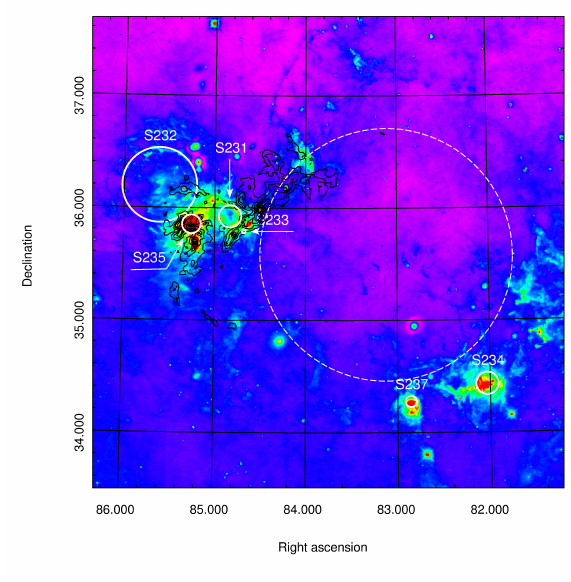
Figure 1. Image at 22 µ m by WISE centered at α (J2000.0) = 05 h 35 m 00 s and δ (J2000.0) = +35 ∘ 36 ′ 36 ′′ . The intensity scale uses an asinh stretch. Black contours represent 13 CO emission of giant molecular cloud G174+2.5 from FCRAO14-m telescope by Ladeyschikov et al. (2016). Contours are generated from 1 to 150K kms −1 . White circles show optical H ii regions from the Sharpless catalogue Sharpless (1959). White dashed circle shows unidentified bubble-shaped nebula.